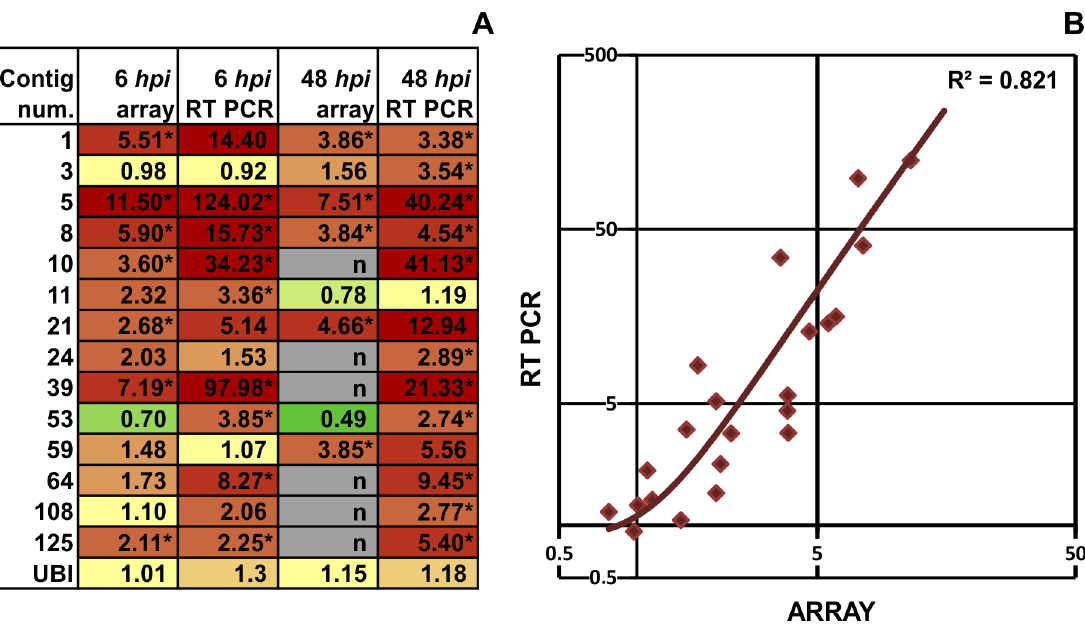
Figure 2. Validation of microarray results by real time RT-PCR. A) Heat map diagram of the expression ratios of randomly selected genes obtained by microarray hybridization and real time RT-PCR. Tobacco leaves were infiltrated with P. syringae pv. syringae hrcC - bacteria suspension or water, samples were taken 6 and 48 hours later. Values are averages of three independent biological replicates. Stars indicate significant gene activation greater than 2-fold (p , 0.05) as compared to water treated controls. Color coding: red: activation, green: repression, yellow: no significant activity change. The letter ‘‘n’’ means no data available. B) Correlation of the RT-PCR and microarray derived expression ratios of the genes from part A). RT-PCR ratios (both 6 and 48 hpi) from the table in Fig. 2A) were drawn on the y axis, while array derived ratios were drawn on the x axis of the graph. Both axes are on a logarithmic scale. The best fitting regression trend line was found to be an order 2 polynomial regression trend line having the highest r-squared (R 2 ) value with p , 0.01.